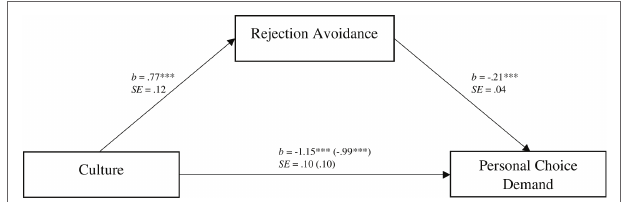
FIGURE 4 | Individual levels of rejection avoidance as a mediator of the cultural differences in personal choice demand as a reaction to vicarious choice in Study 2. Unstandardized coefficients and standard errors are shown. Coefficients indicating the relationship between culture (coded as German culture = 0 and Japanese culture = 1) and acceptance of vicarious choice after controlling for rejection avoidance tendencies are given in parentheses. *** p <